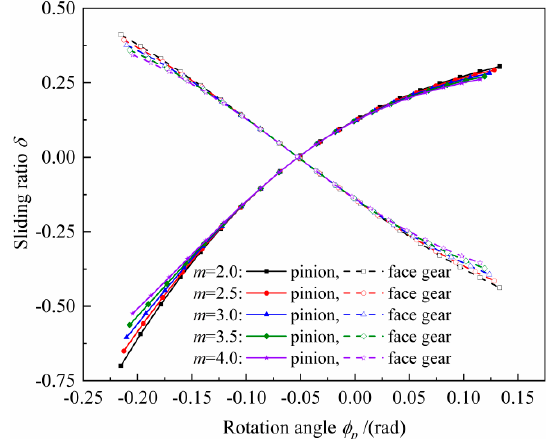
Figure 10. Effect of module m on sliding ratio.